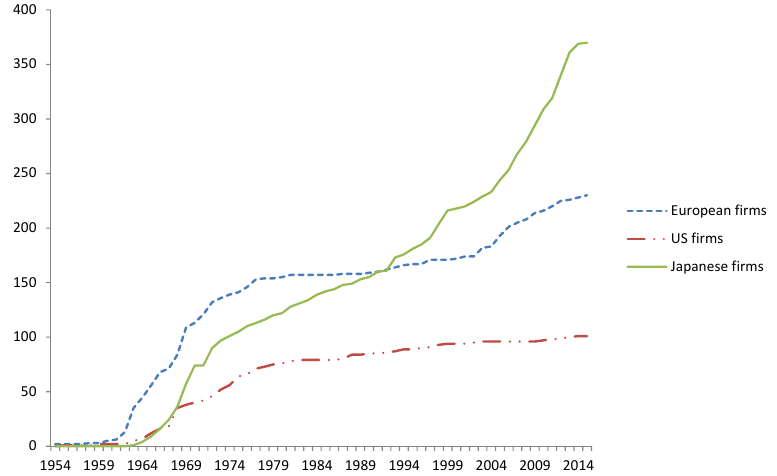
Figure 2. Patent applications by Japanese, US, and European firms Source: Created by author from J-PlatPat search